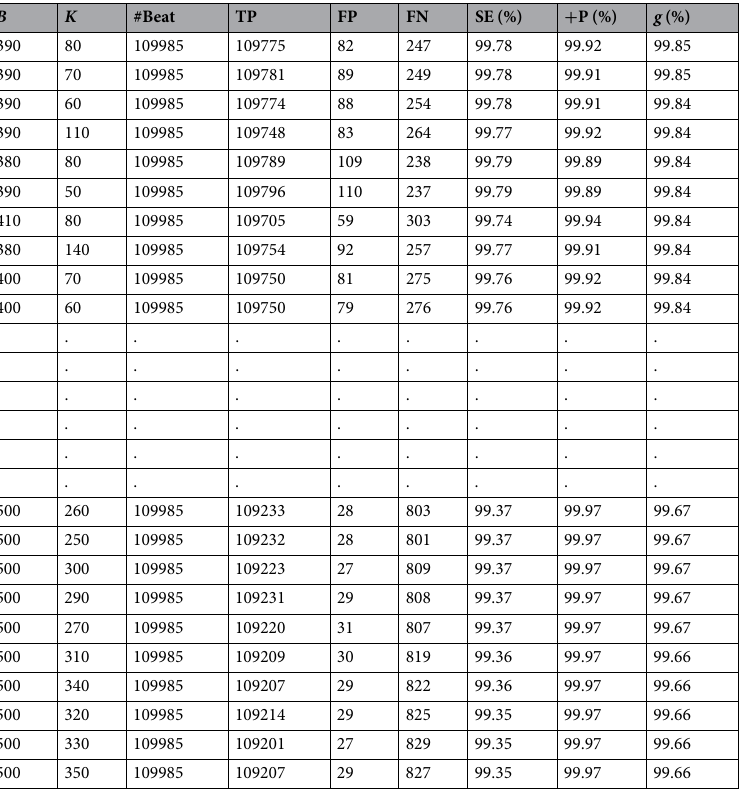
Table 1. Optimal values for Method III based on the QRS detection accuracy. Results were sorted in descending order according to the overall accuracy (objective function g ). TP stands for true positives (the number of QRS complexes detected as QRS complexes), FN stands for false negatives (the number of QRS complexes which have not been detected), FP stands for the number of false positives (non-QRS complexes detected as QRS complexes), SE stands for sensitivity, + P stands for positive predictivity, and g is the F-score (the harmonic mean of SE and +